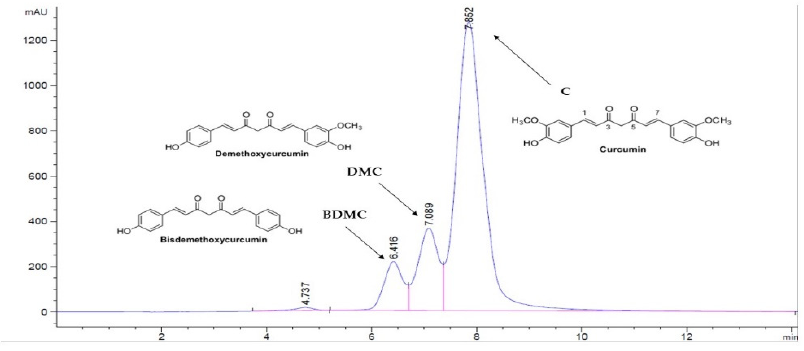
Figure 1. Chromatogram of turmeric extracts using HPLC and chemical structure of curcumin. Different methods have been reported for the isolation of curcumin and other curcu ‐ minoids from turmeric powder, such as conventional solvent extraction, hot and cold per ‐ colation, and Soxhlet extraction and advanced or novel methods based on microwave ‐ assisted extraction (MAE) and ultrasonic ‐ assisted extraction (UAE) [10]. Conventional ex ‐ traction methods are routinely associated and use high temperatures and large amounts of solvent, and have long extraction times and sometimes poor extraction efficiency [11].